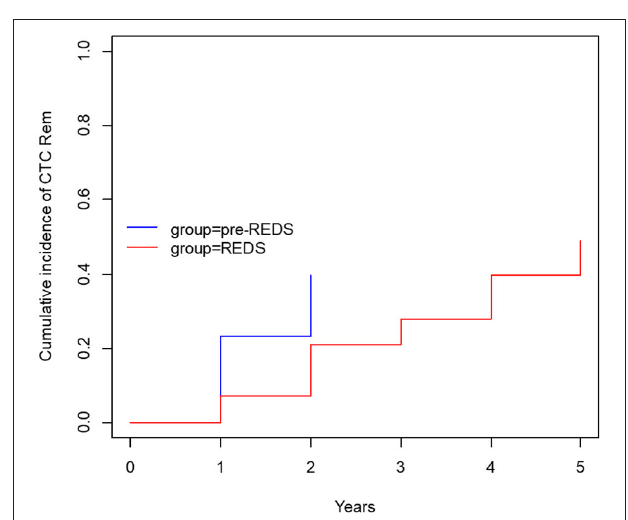
FIGURE 3 | The cumulative incidence of CTC removal with concurrent ESI (R3 and R4) and CRBSI (before and after